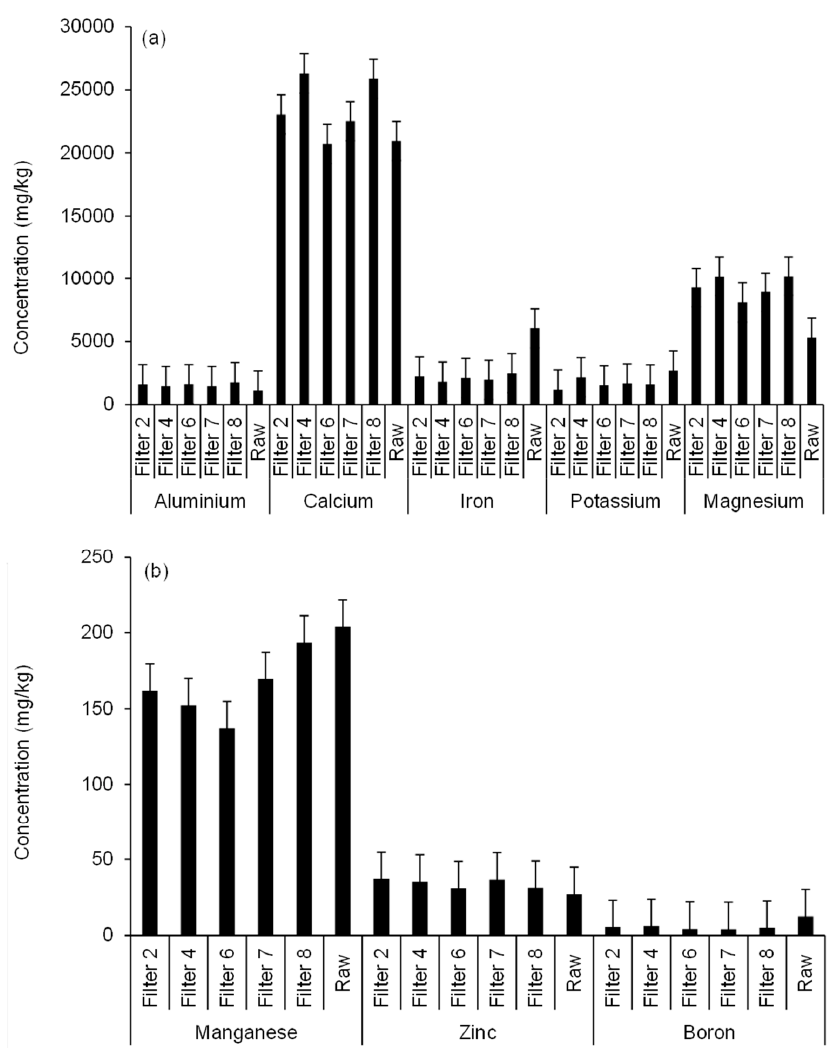
Figure 4. Inductively coupled plasma optical emission spectrometer analysis for elements in the irrigated soil: ( a ) aluminum, calcium, iron, potassium and magnesium; and ( b ) manganese, zinc and